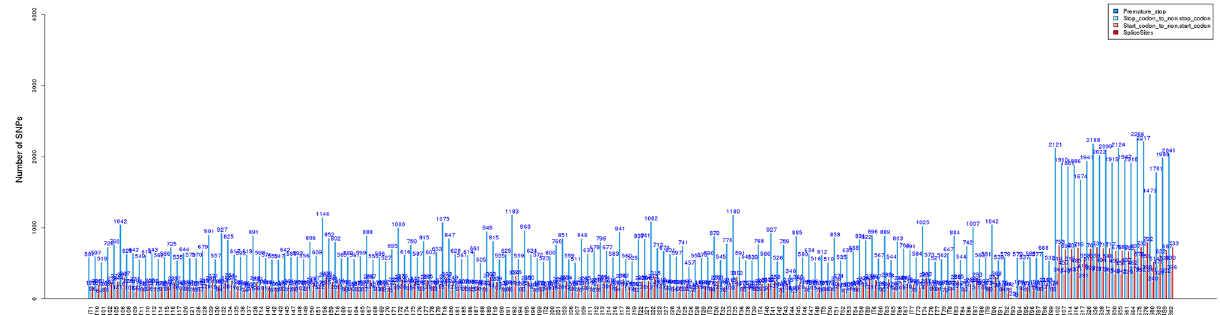
Figure 3. Statistics of different types of large-effect SNPs. Re-sequenced entries are represented on x-axis, numbers on top of each bar represent the number of SNPs 74